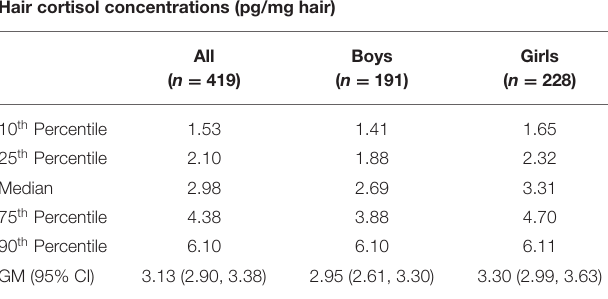
TABLE 2 | Descriptive statistics of hair cortisol concentrations of all participants and stratified by sex. Hair cortisol concentrations (pg/mg hair)